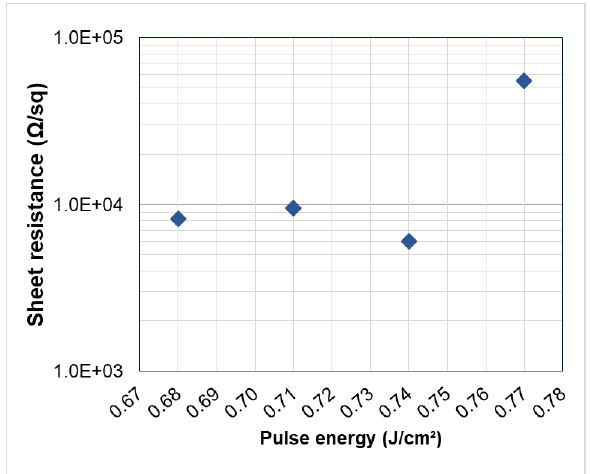
Figure 5: Sheet resistance as a function of the laser energy density for 6 nm SiGeOI ( x Ge = 0.25) layer implanted with boron.